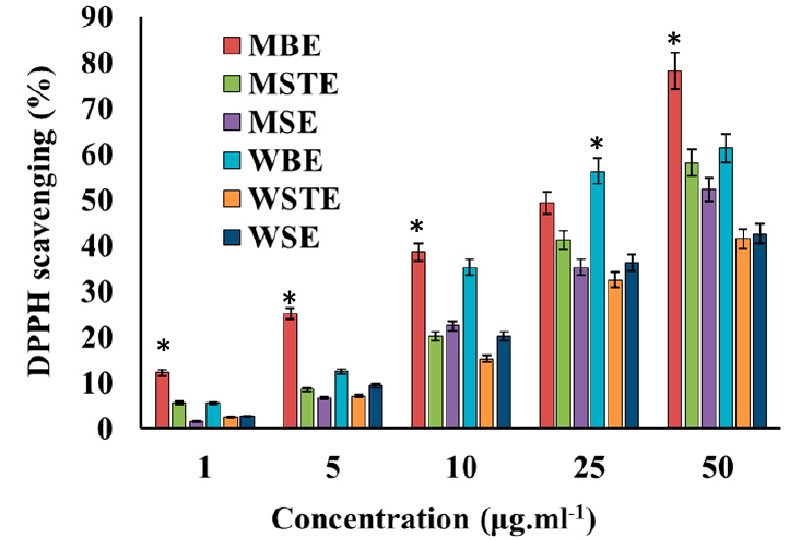
Figure 1. Antioxidant activity; 1,2-diphenyl-1-picrylhydrazyl (DPPH) scavenging efficiency of the methanolic and water extracts of T. vernicifluum . Methanolic seed extract (MSE), methanolic bark extract (MBE), methanolic seed extract (MSTE), water seed extract (WSE), water bark extract (WBE), water stem extract (WSTE). Data are mean ± standard error (SEM, n = 3). * p < 0.05 significantly differs with other extracts.